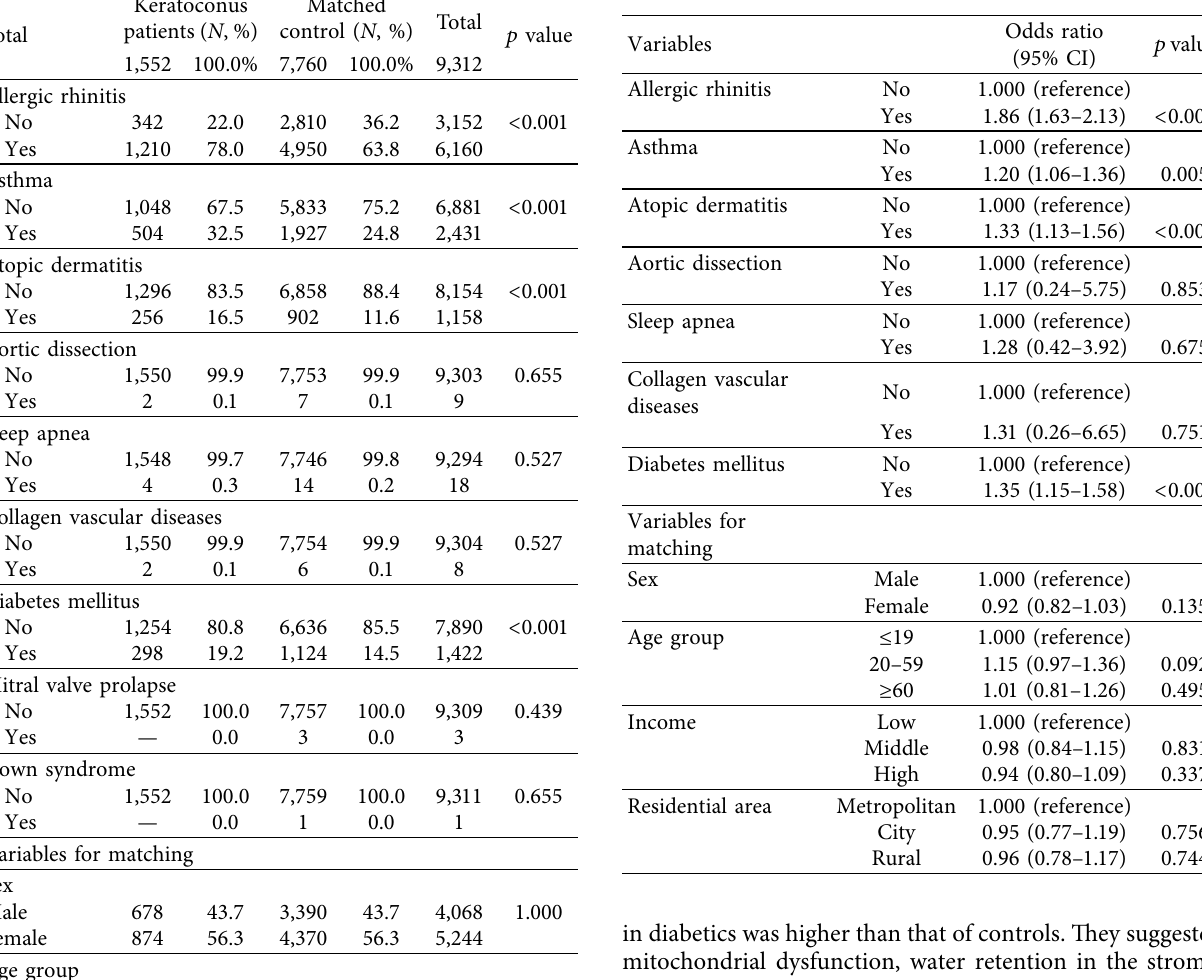
Table 2: Characteristics of study population. Table 3: Logistic regression model estimating associations of covariates with